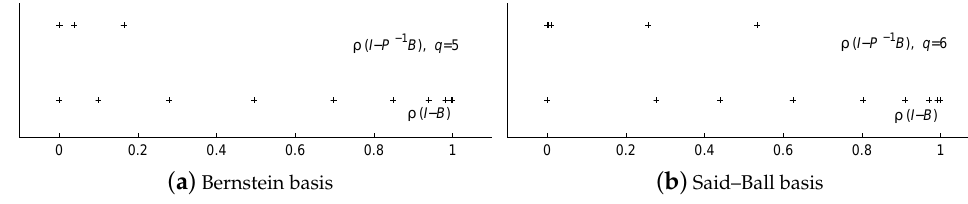
Figure 1. Spectral distributions of matrices I − B and I − P − 1 B in Example 1.